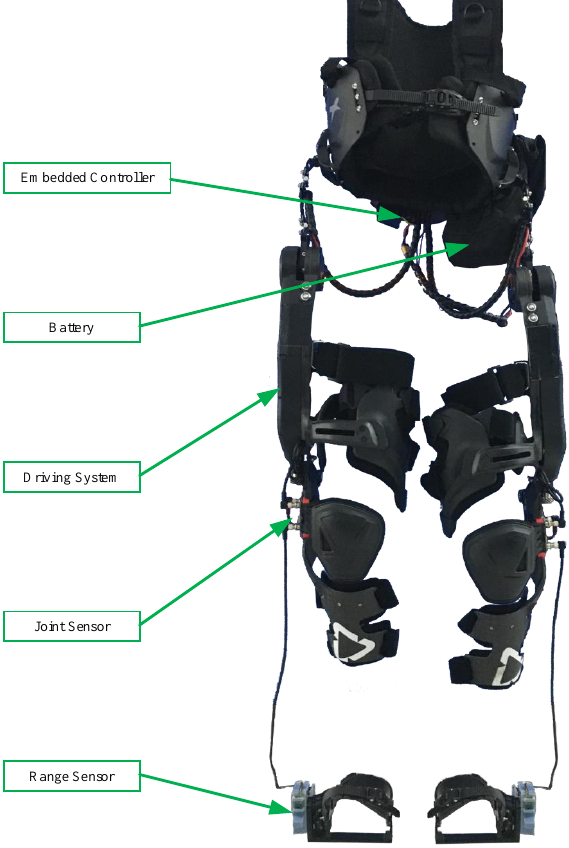
Figure 6. Exoskeleton prototype. The exoskeleton robot had active hip and knee joints on the sagittal plane and a negative hip joint on the frontal